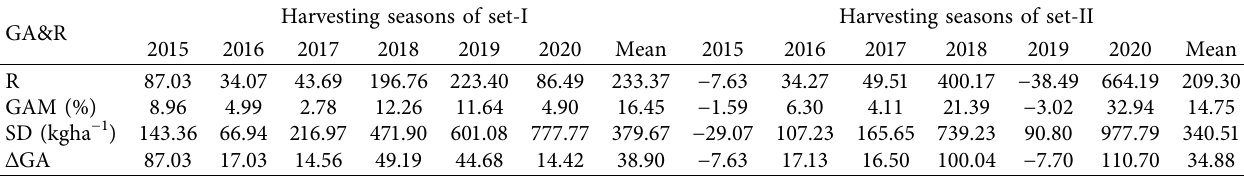
Table 5: Annual genetic gain and response to selection in yield.